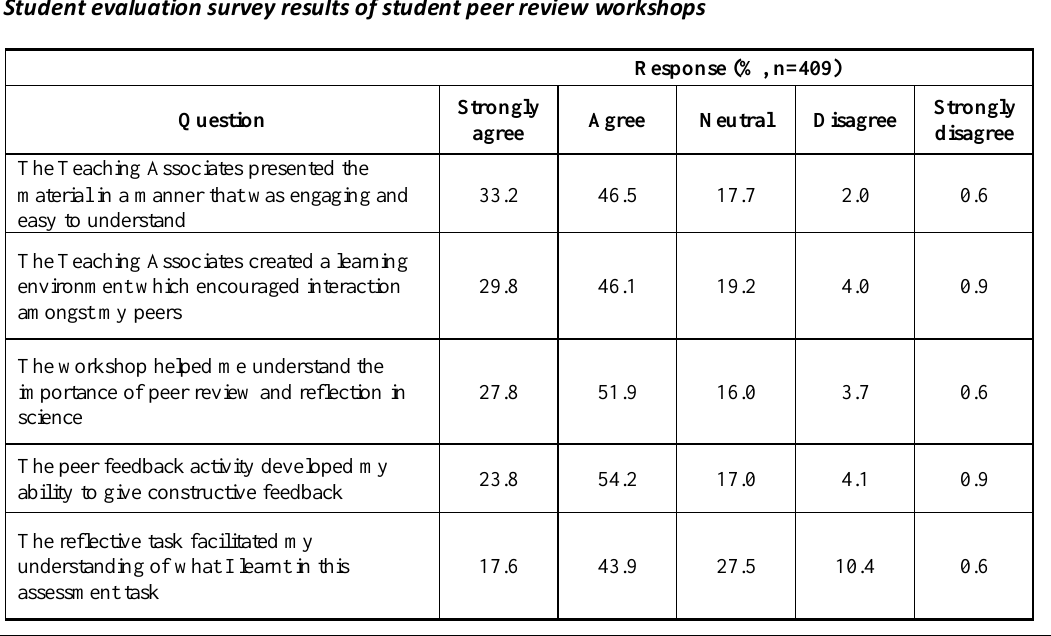
Student evaluation survey results of student peer review